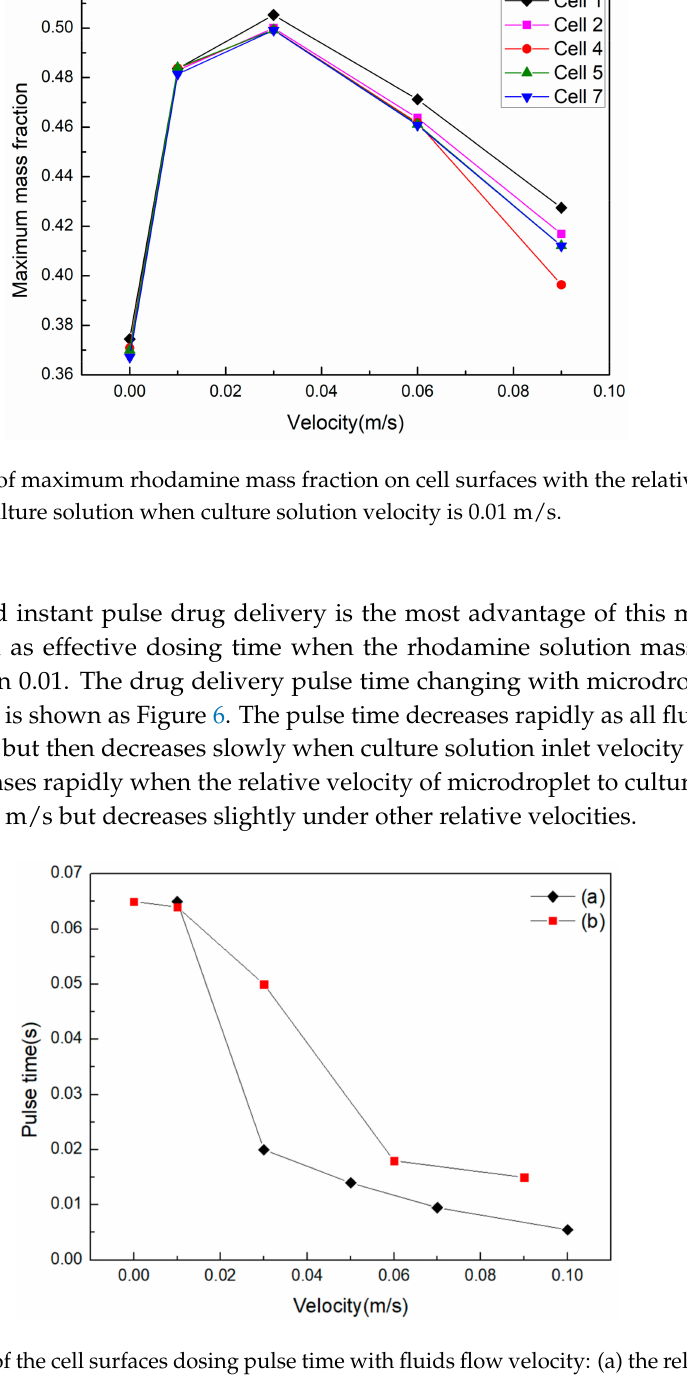
Figure 6. Change of the cell surfaces dosing pulse time with fluids flow velocity: (a) the relative velocity between microdroplet and culture solution is 0 m/s and microdroplet and culture solution velocity change from 0.01 m/s to 0.1 m/s; (b) change of the relative velocity of microdroplet to culture solution from 0 to 0.09